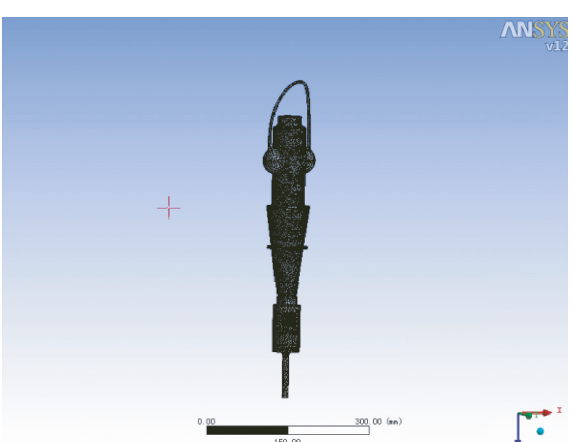
Figure 5: The mesh model.